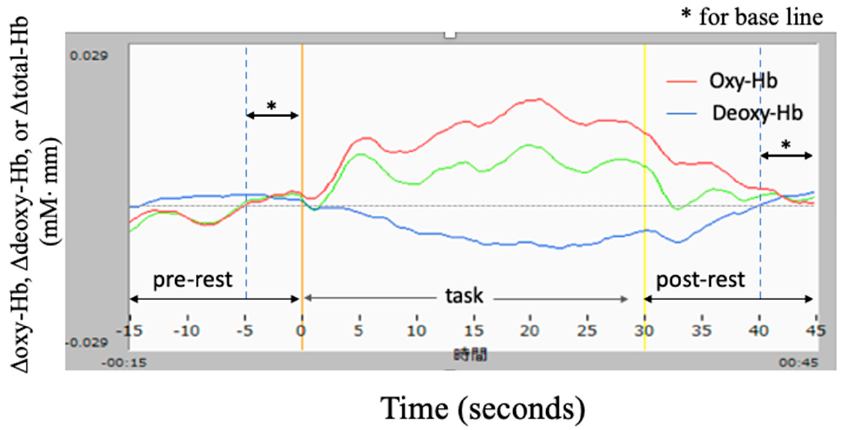
Figure 3. Sample waveforms of cerebral blood flow obtained from a channel in a subject: red, Δ oxy-Hb (oxy-hemoglobin change); blue, Δ deoxy-Hb; green, Δ total-Hb.